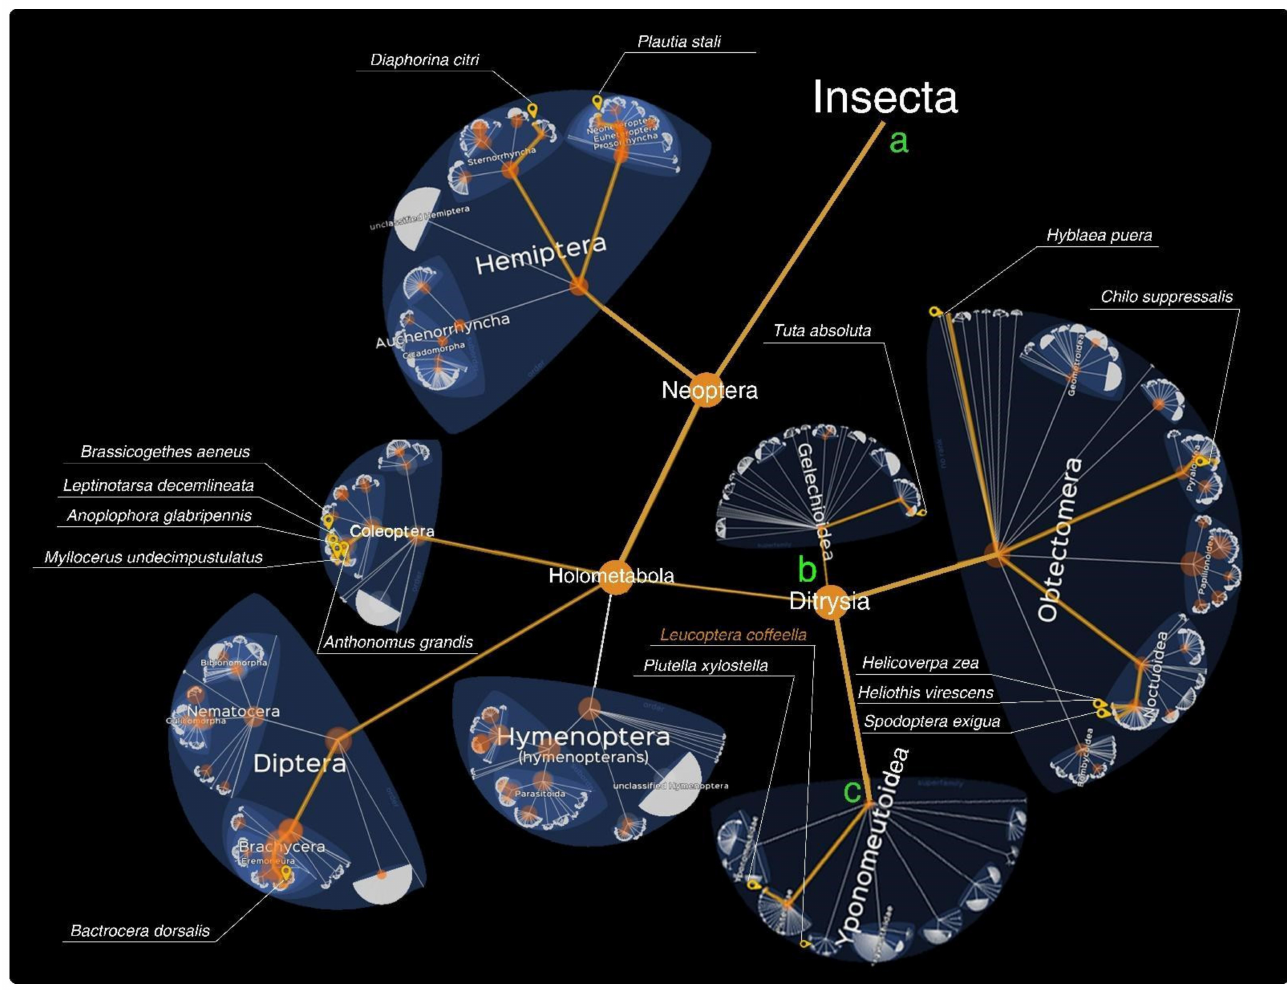
Figure 1. Main taxonomic levels are depicted in a tree, modified from https://lifemap-ncbi.univ- lyon1.fr/ (accessed on 21 September 2022), showing the Insecta class ( a ), the Ditrysia clade ( b ) and the Yponomeutoidea superfamily ( c ). Orange spheres highlight the levels with fully sequenced genome data. Insect species listed in Tables 1 and 2 (written in white) are marked by a yellow tag. The L. coffeella in the Lyonetiidae family is written in